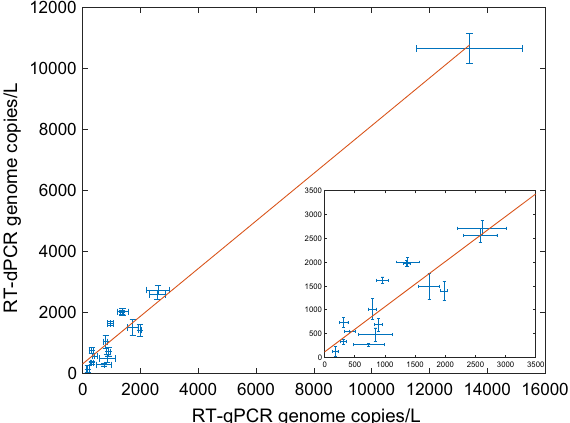
Figure 3. Comparison of RT-qPCR and RT-dPCR quantitative results for 16 paired, untreated samples. (Data presented ± standard deviation of the mean, unweighted least-squares fit shown in the orange line, r 2 = 0.98, slope = 1.2. Insert—data and unweighted fit for lower amplitude signals, r = 0.87, slope =